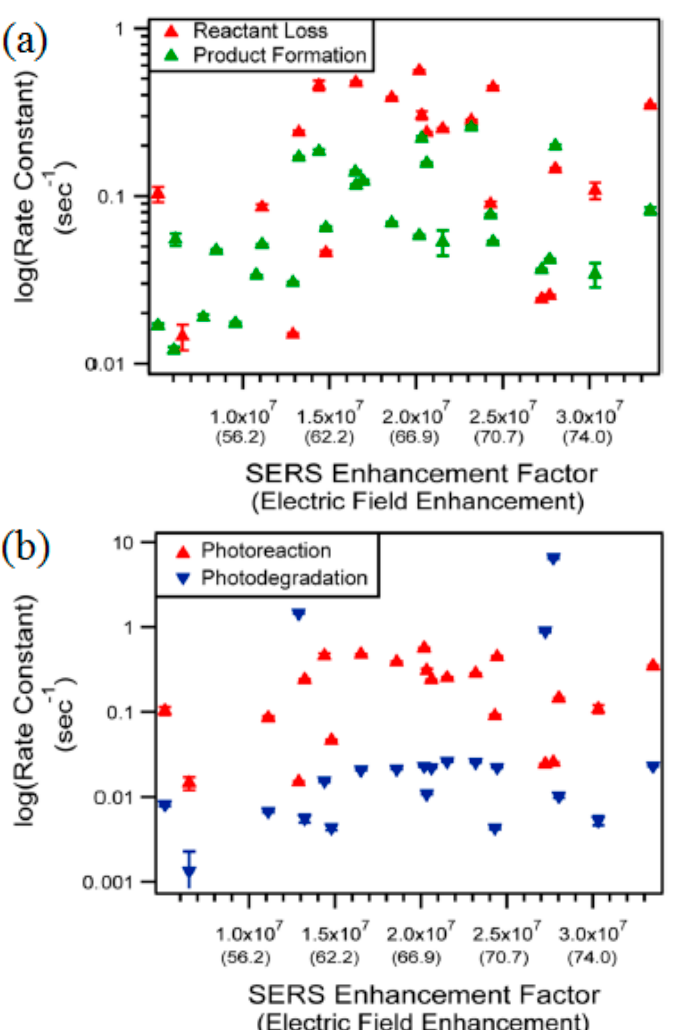
Figure 11. Rate constants for plasmon-induced processes. ( a ) Comparison of photoreaction rate constants with the loss of the 4NBT reactant (red), and formation of the DMAB product (green); ( b ) comparison of the photoreaction rate for 4NBT (red) and the photodegradation rate of 4NBT (blue). All observed ensemble-averaged rates are independent of field enhancement for the range of probed EFs [45].